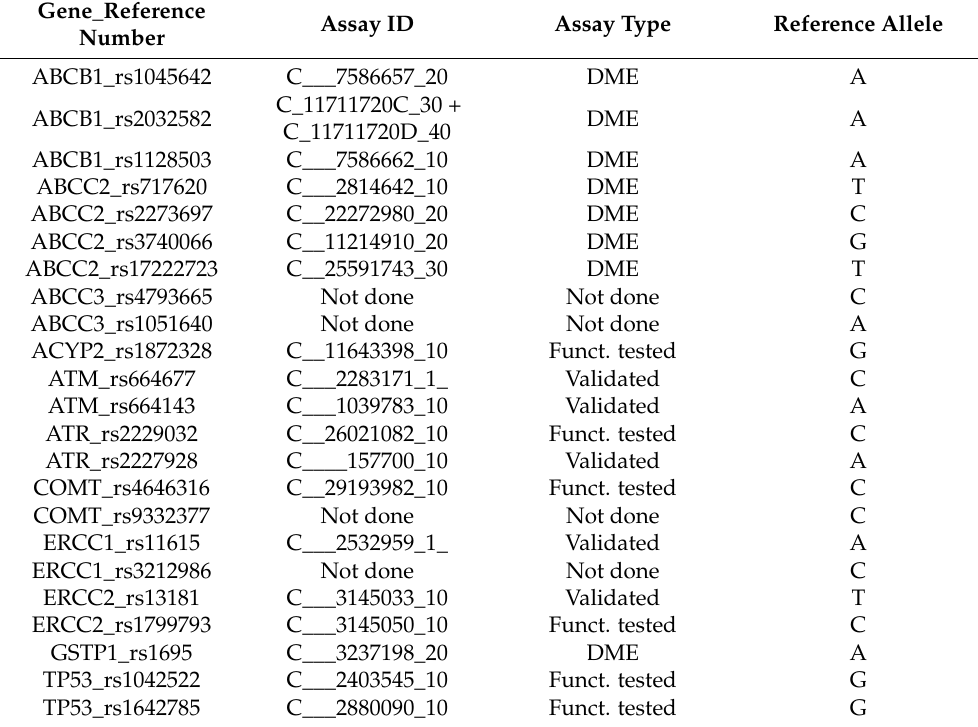
Table A2. Assays used for TaqMan genotyping and reference allele of multimodal targeted next generation sequencing (mmNGS) for variant